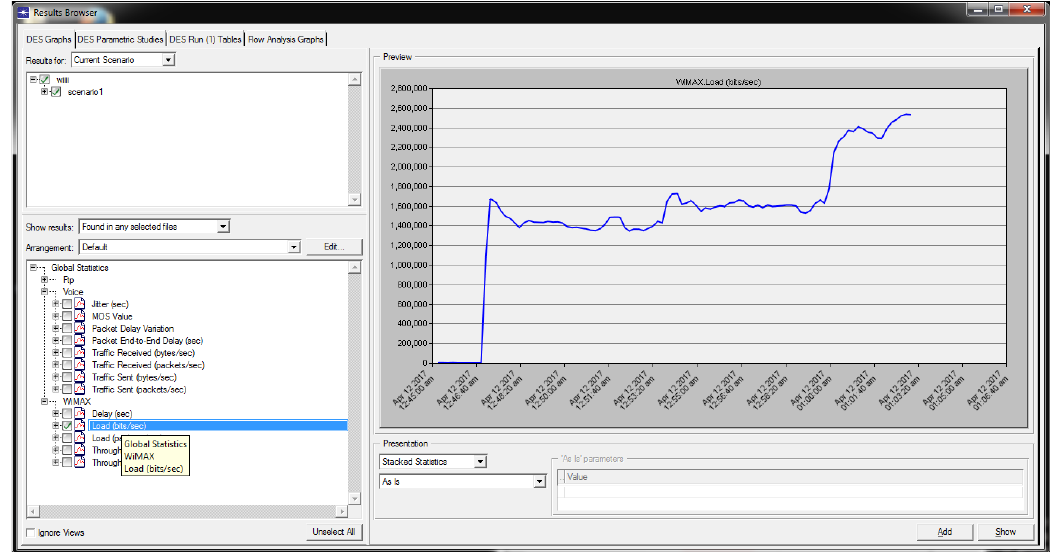
Fig. 5. Global Statistics WiMax Load bits/second for overall network, reaches 2580000 (2.58Gbps) bit per second